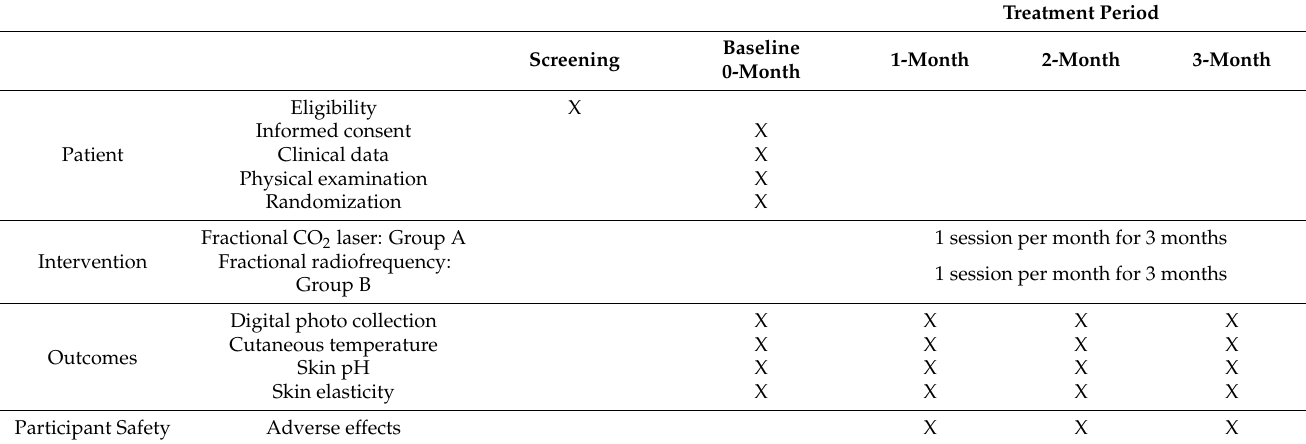
Table 1. Timing of visits and data collection, according to the Standard Protocol Items: Recommenda- tions for Interventional Trials